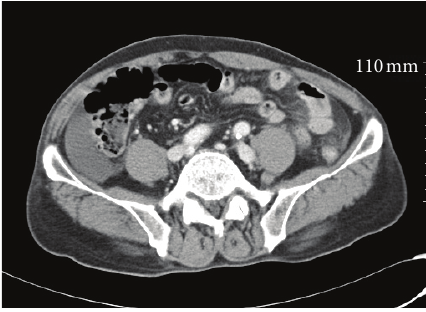
Figure 1: Abdominal computed tomography (CT) revealed fluid accumulation in the paracolic gutter on the right side.